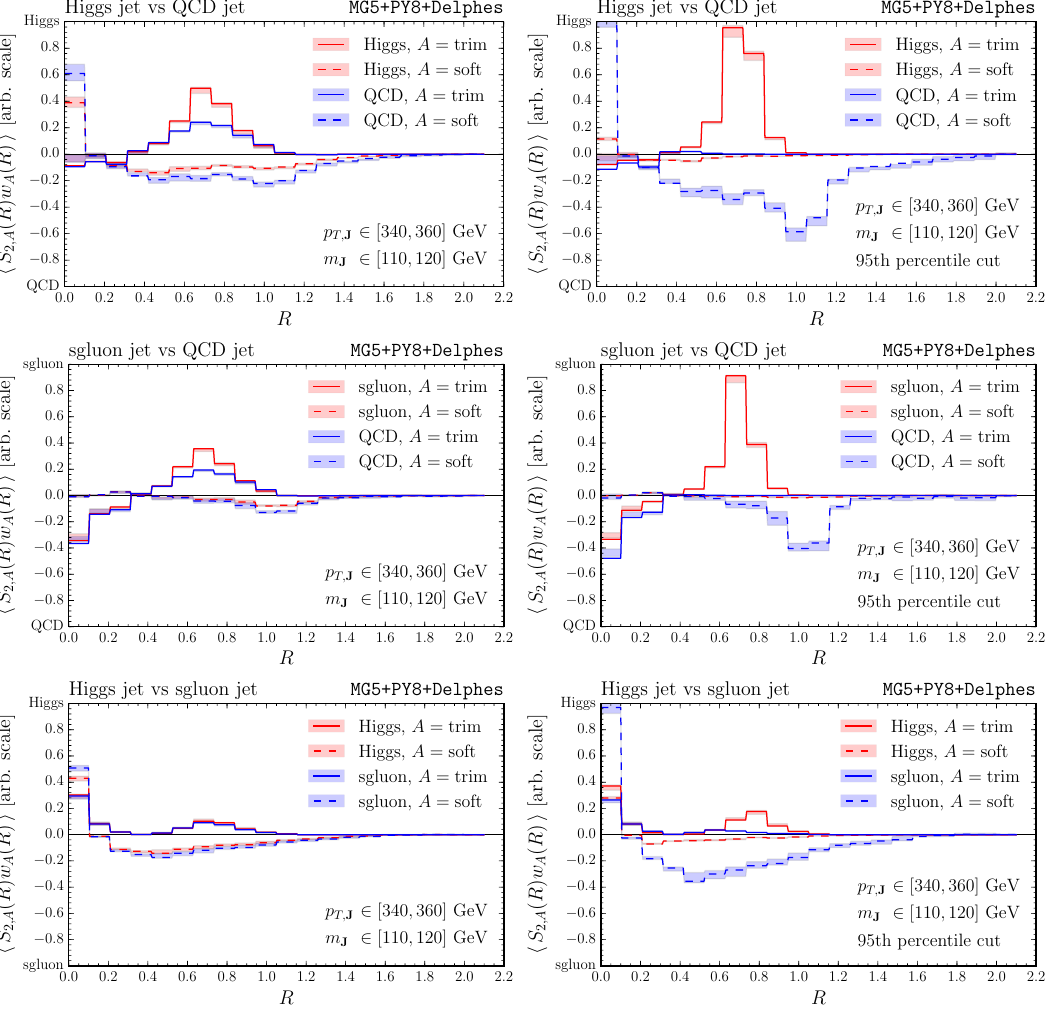
S 2 ; trim ( R ) w trim ( R ) (solid) and S 2 ; soft ( R ) h i h S 2 ;A ( R ) w A ( R ) for Higgs jet vs. QCD jet (top), sgluon jet h i